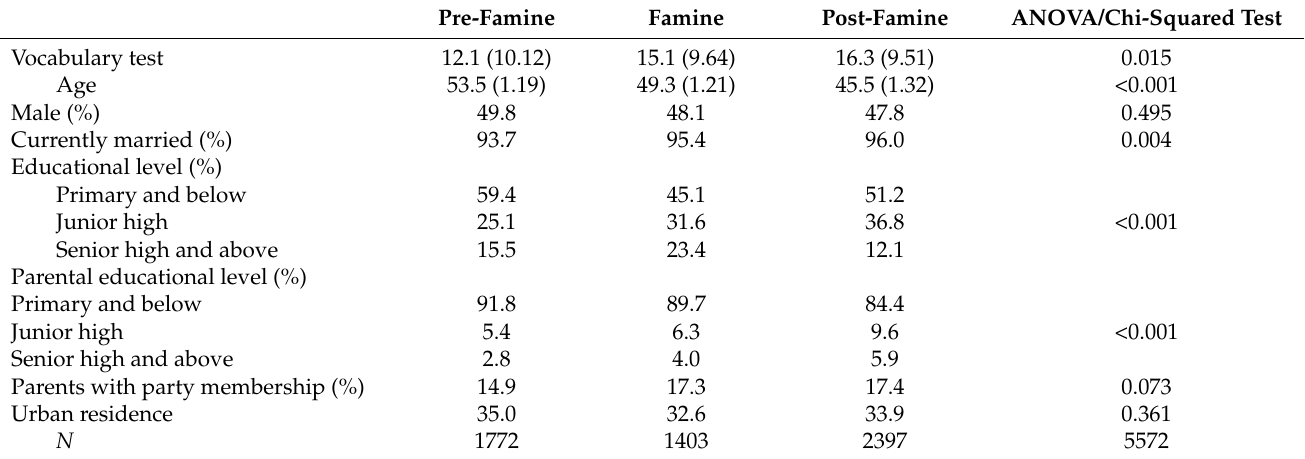
Table A1. Summary statistics for selected variables of CFPS 2010 (the cohort comparisons